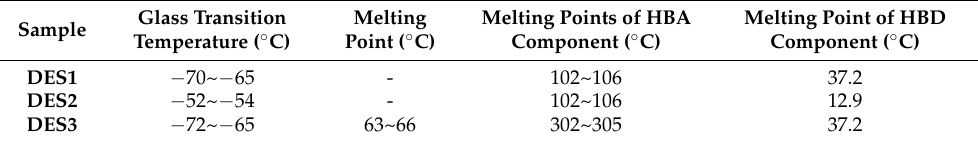
Table 1. Glass transition temperatures and melting points of